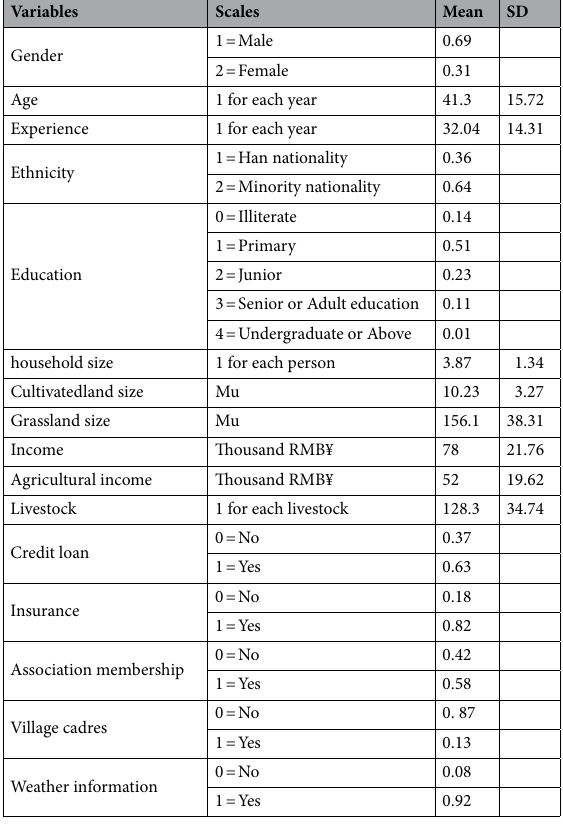
Table 2. Descriptive statistics of agro-pastoralist